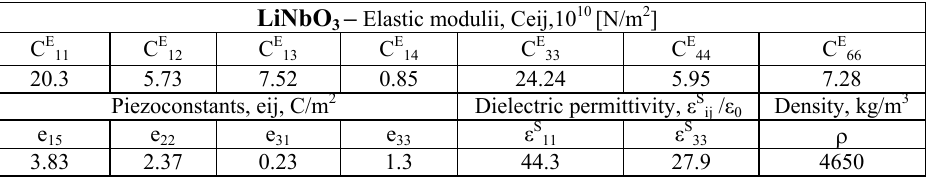
Table 1. The material constants of LiNbO 3 crystal [5]